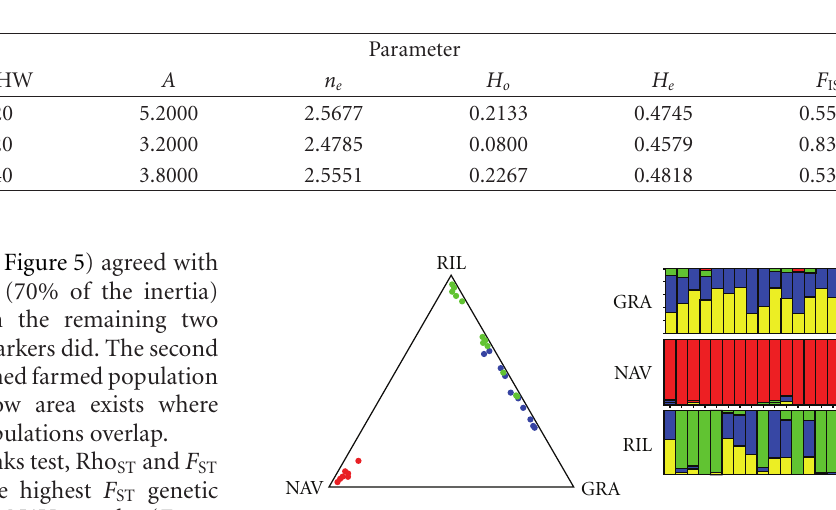
Figure 4: Summary of the clustering results for the A. italicus data assuming three populations. Each point shows the mean estimated ancestry for an individual in the sample. For a given individual, the values of the three coe ffi cients in the ancestry vector q ( i ) were given by the distances to each of the three sides of the equilateral